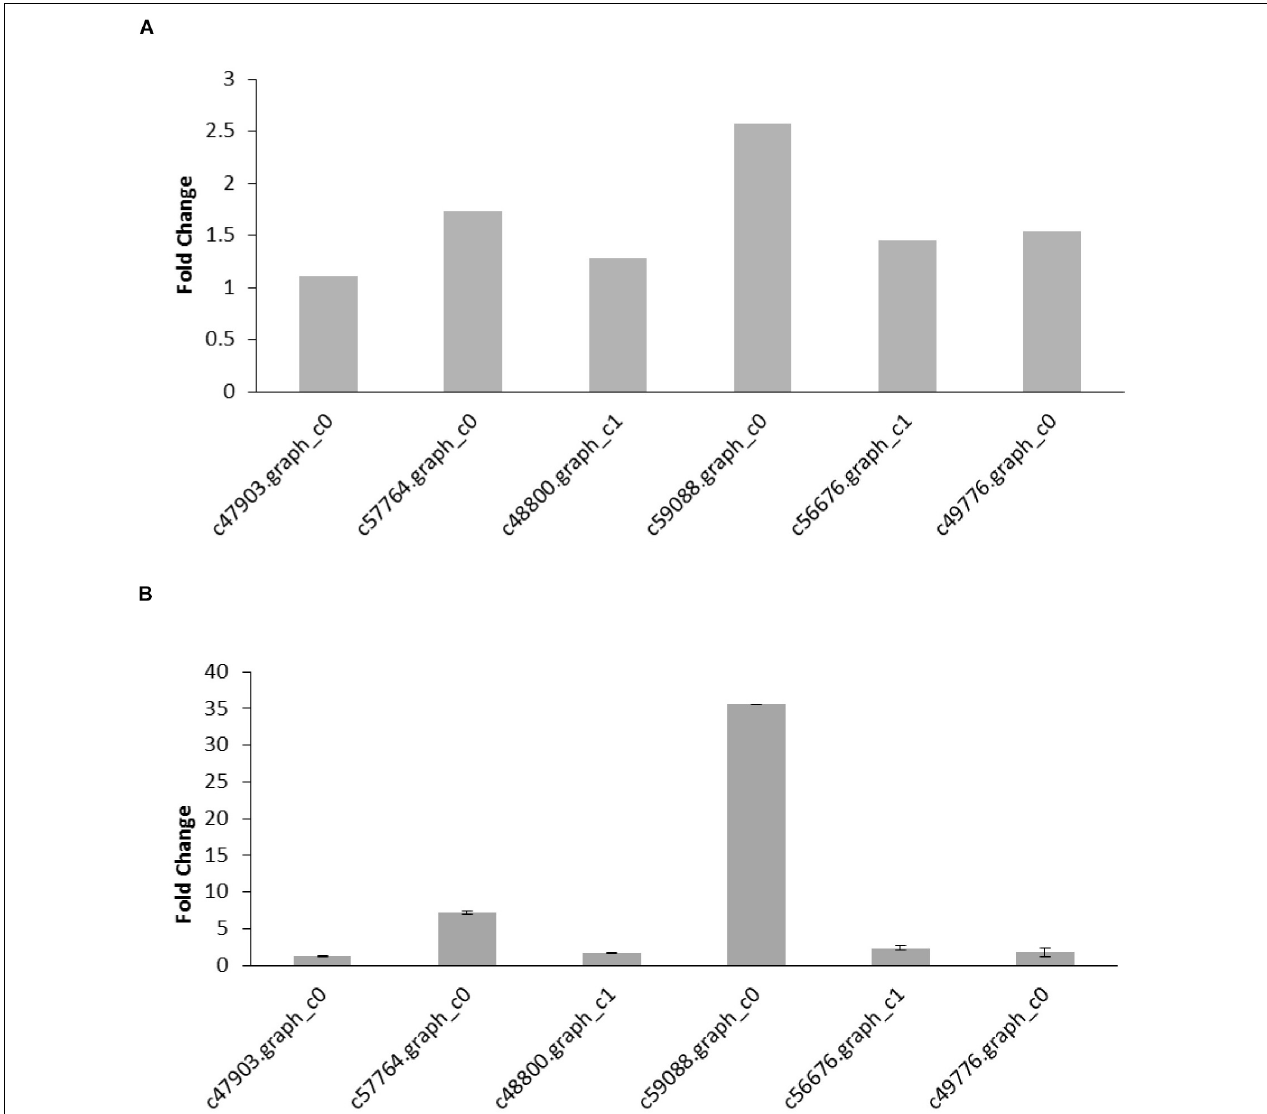
FIGURE 4 | (A) DEGs identified from the transcriptome analysis. The fold change of the gene was calculated as a log 2 value shown on y-axis. (B) qRT-PCR results of gene expression. The values are expressed as the means ± SEs of three independent biological